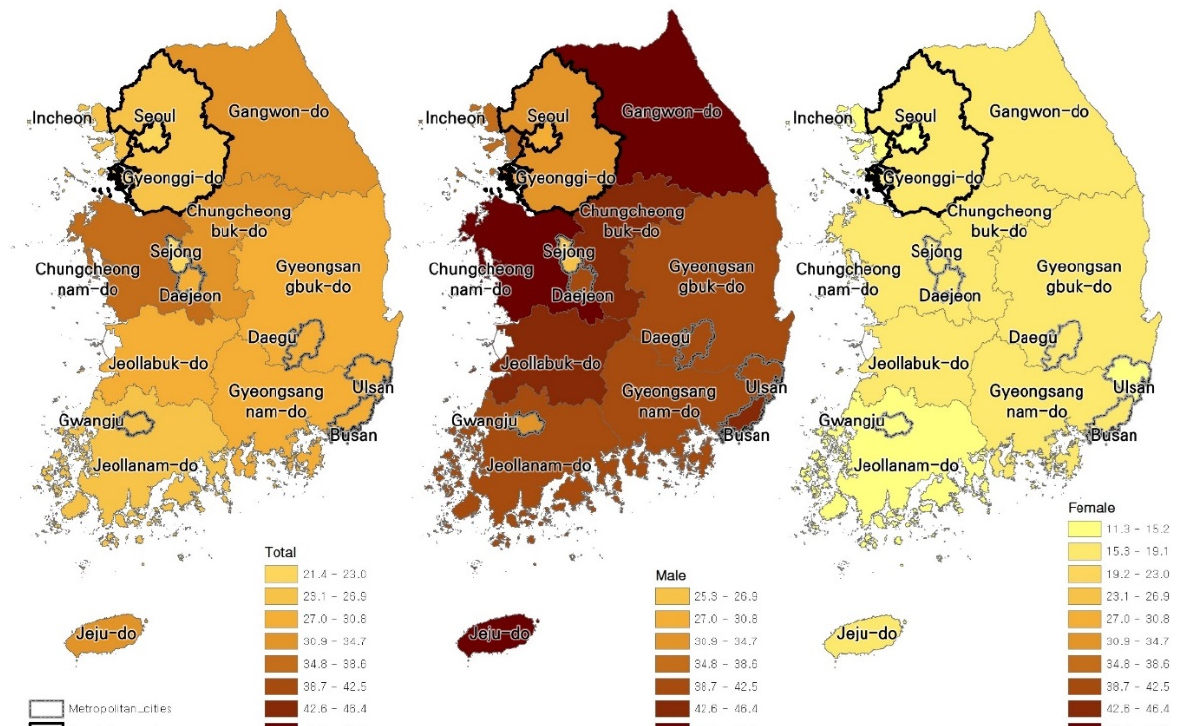
Figure 1. Suicide rate in South Korea for 2019, based on gender.